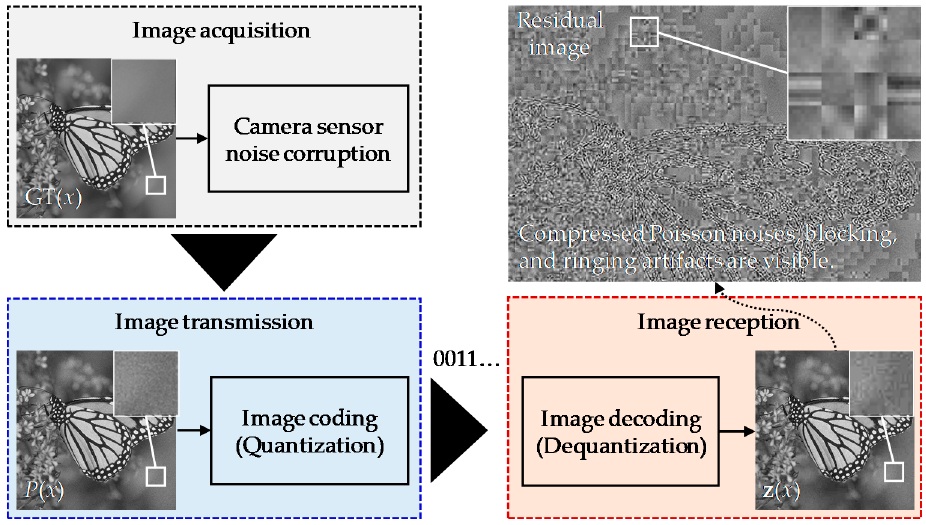
Figure 2. Image degradation model due to the coding of Poisson noisy images.